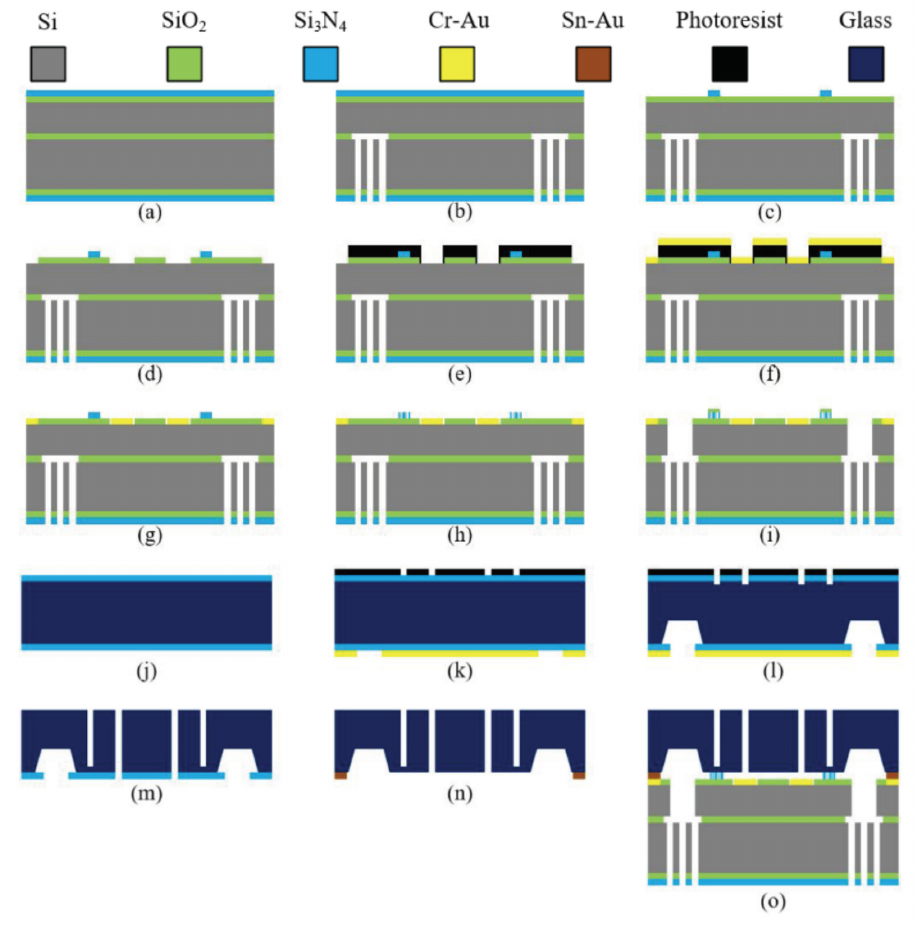
Figure 14. MEMS fabrication process of the